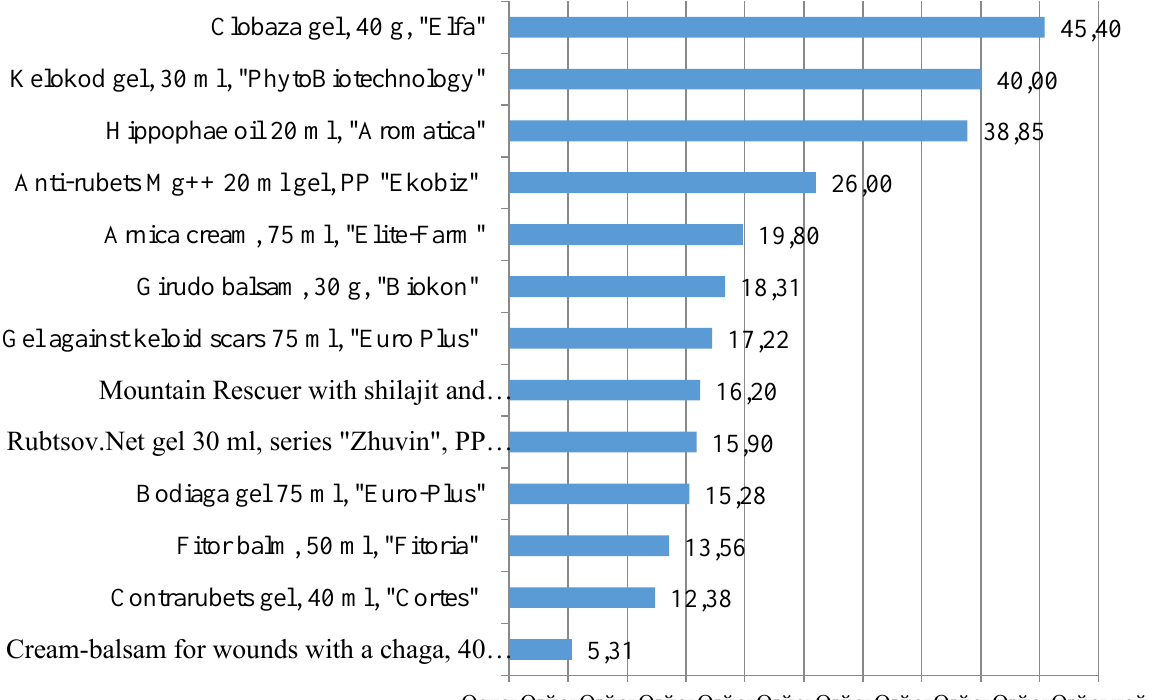
Fig. 2. Analysis of the coefficients range of variability by the AKPF